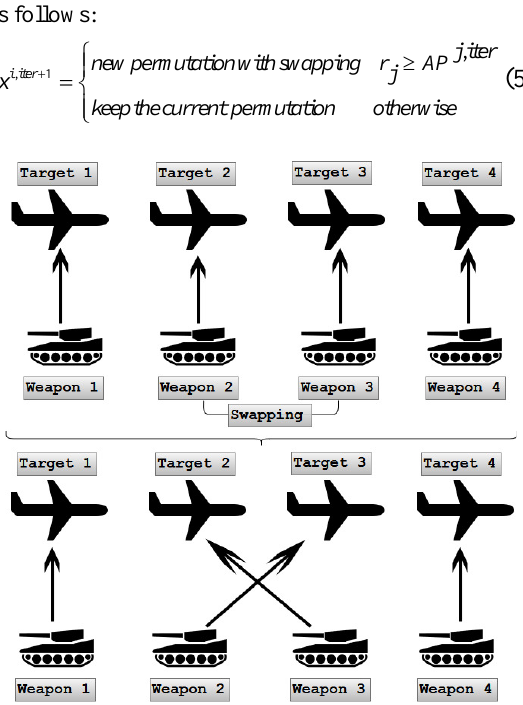
Figure 3. Illustration of swap operator for neighborhood solution.